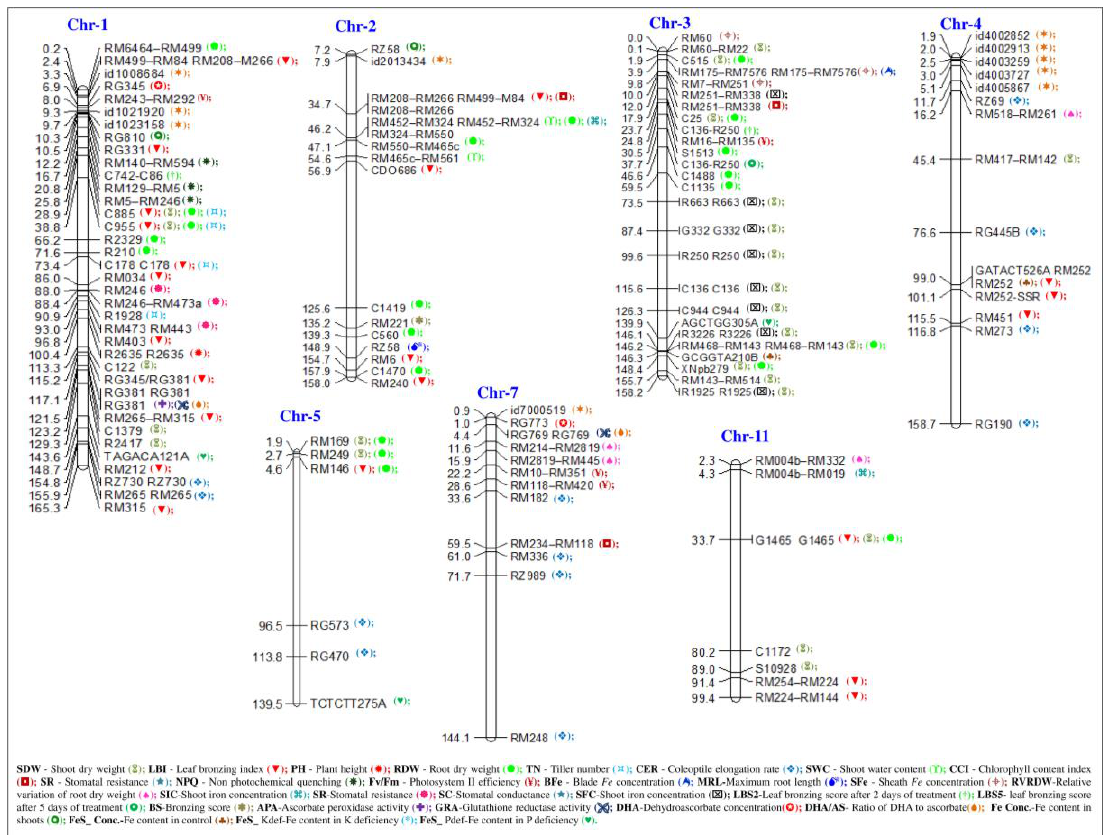
Figure 3. Comprehensive literature survey for the quantitative trait loci (QTLs) associated with Fe metabolism in rice.